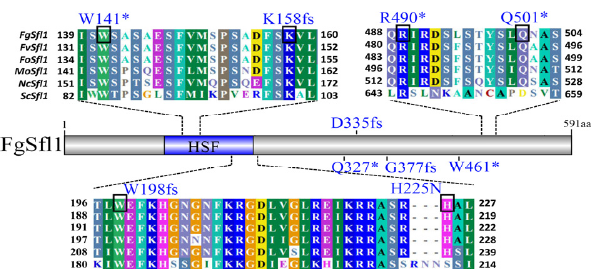
Figure 3. Schematic drawing of mutation sites identified in SFL1. Amino acid changes in SFL1 identified in 25 suppressor strains are labeled above the schematic drawing of Sfl1 or sequence alignments of Sfl1 and its orthologs from Fusarium oxysporum (Fo), Fusarium verticillioides (Fv), Magnaporthe oryzae (Mo), Neurospora crassa (Nc), and Saccharomyces cerevisiae (Sc). The conserved amino acid residues with suppressor mutation in Sfl1 are labelled with black boxes. The predicted heat shock transcription factor binding domain (HSF) are labelled with the blue box. “fs”, frameshift variant; “*”, stop gained. Table 3. Phenotypes of the Fgsfl1 mutant in growth, conidiation, and plant infection.